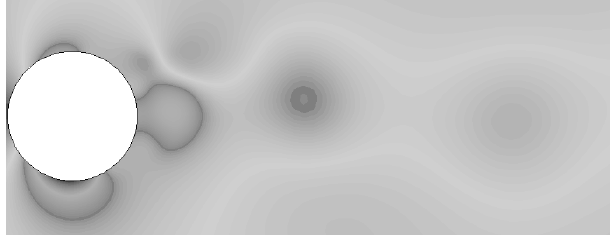
Fig. 3. Prediction of an instant static pressure field behind the circular cylinder for Re = 157 140.